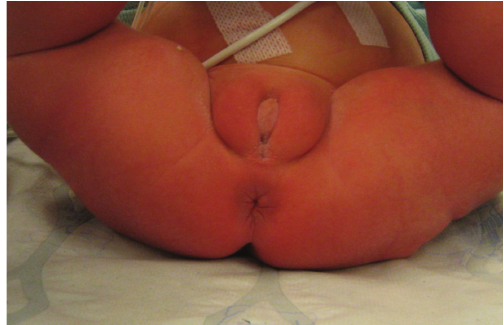
Figure 1: Normal external anatomy at 24hours.